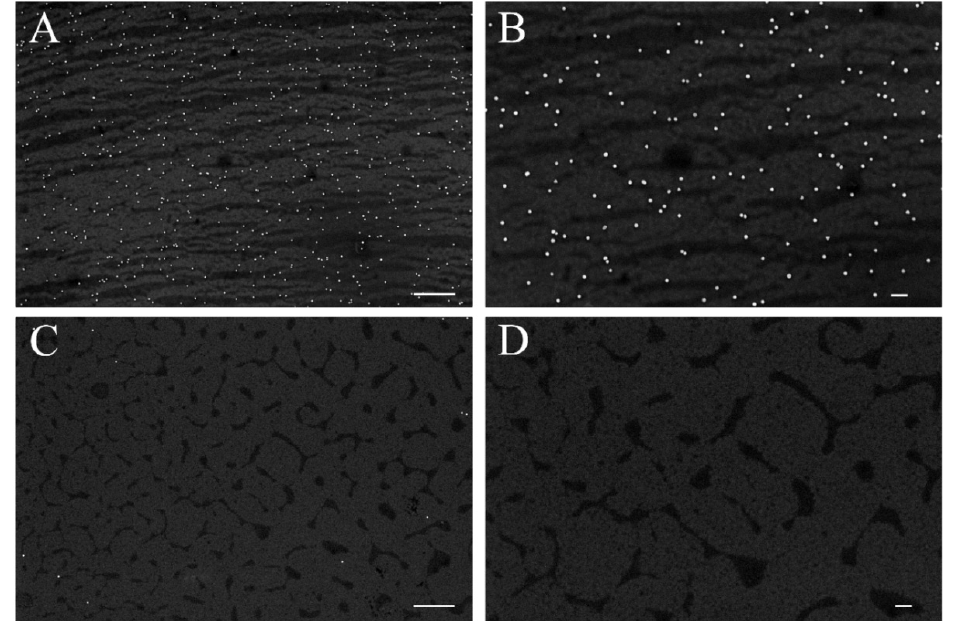
Figure 5. Comparison of presence of AuNPs on the surface of sample chip B1 and negative control chip D1: ( A ) AuNP distribution on chip B1 under 10,000 times magnification, scale bar length 1 μ m;